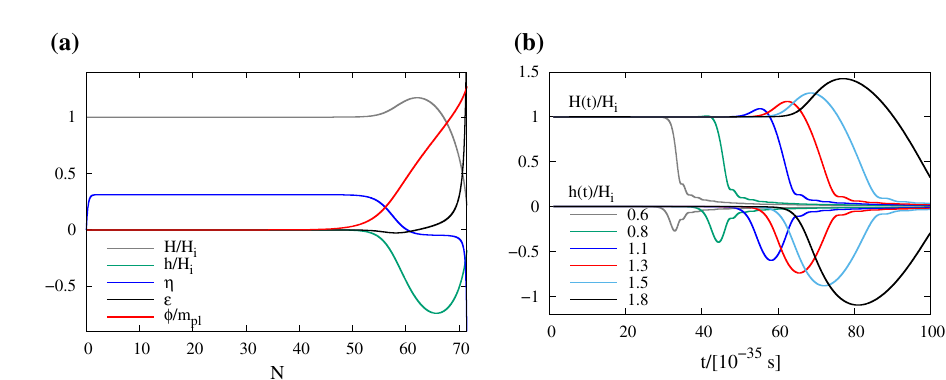
b Evolution of H as a function of the cosmic time t . The size of the bump at the end of inflation depends strongly on the value of φ c (speci- fied in the legend in units of Planck mass). Such a bump is related with the torsion function h ( t ) which is also shown in the